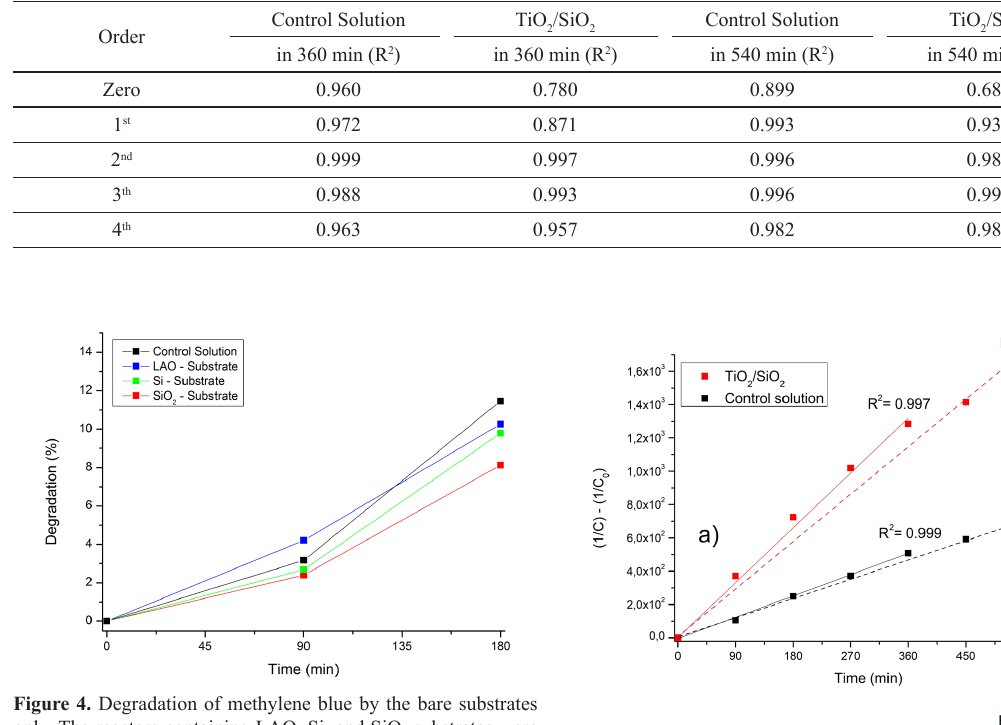
substrates were 2